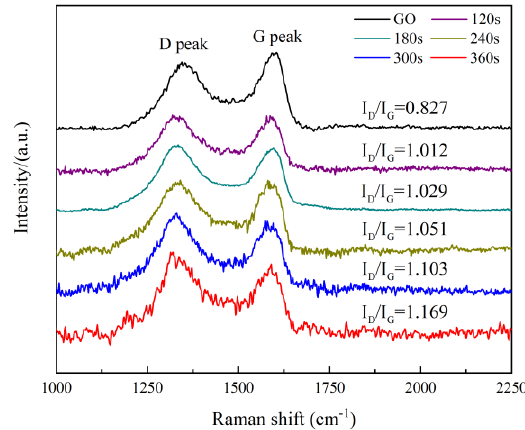
Table 4. The position and the ratio of D peak and G peak.